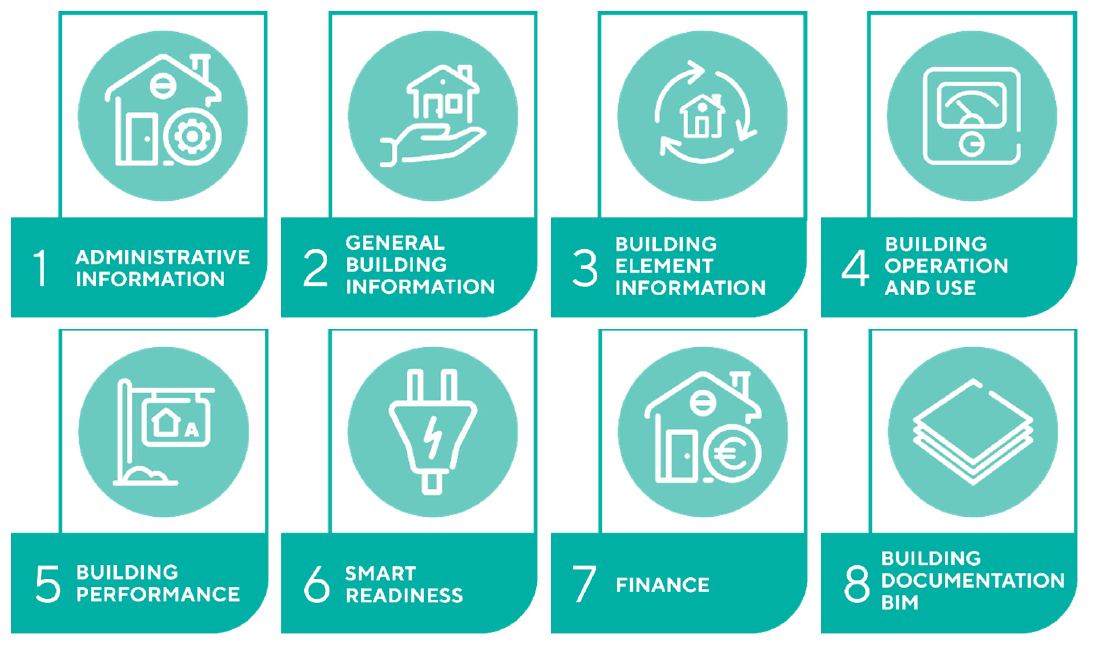
Figure 2 . The main categories of the evaluated EUB SuperHub digital building logbook. Figure 2. The main categories of the evaluated EUB SuperHub digital building logbook.